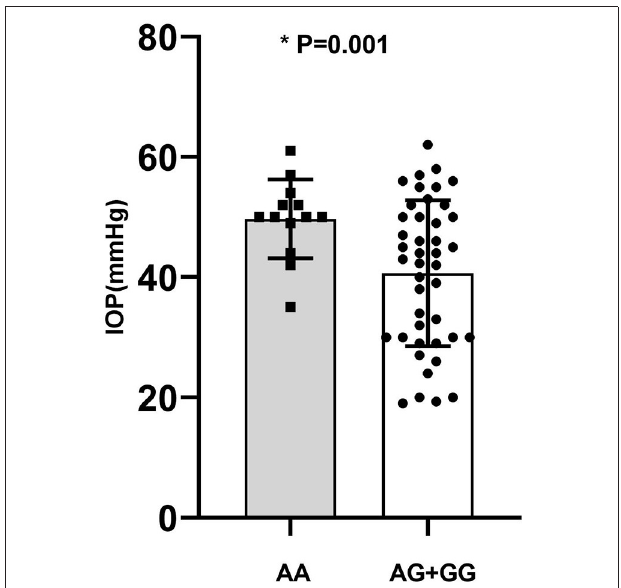
FIGURE 1 | The average of IOP in PSS patients according to genotype of rs800292. AA: 49.69 ± 6.58; AG + GG: 40.67 ± 12.14 (mmHg). *statistical significance.